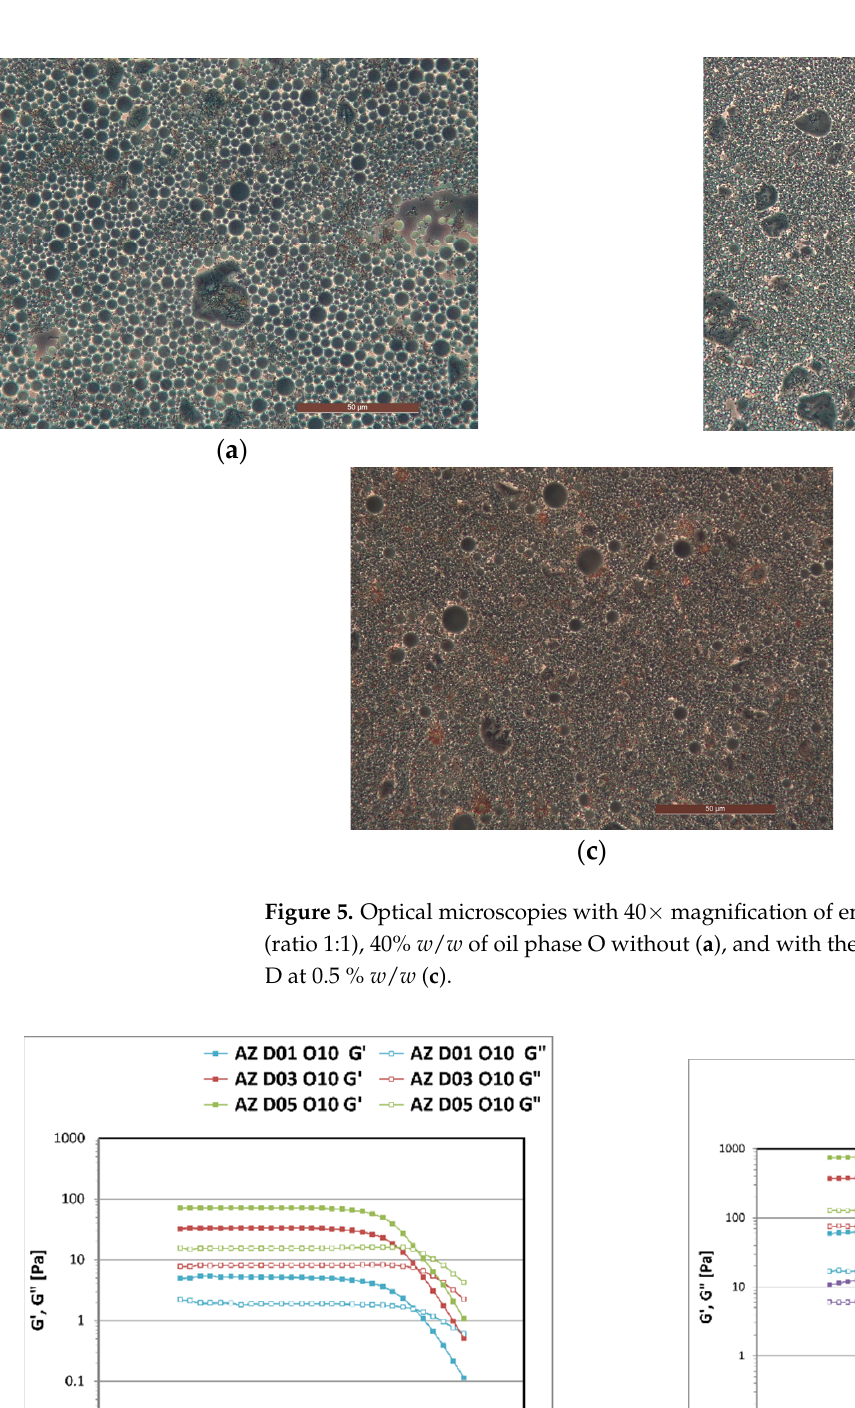
( b ) Figure 4. Optical microscopies with 40× magnification of emulsion AZ10 D03 ( a ) and AZ10 S03 ( b ) prepared with A-Z (ratio 1:1), 10% w/w of oily phase O and 0.3% w/w of polysaccharides D (Diutan gum) and S (Succinoglycan). We evaluated the influence of increasing the concentration of diutan gum (from 0.1 to 0.5% w/w) on the morphological, rheological, and texture properties of the emulsions formulated with 10% of powders (A-Z ratio 1:1) in presence of 10 or 40% w/w of the oily phase. All the systems were stable at the centrifuge test conducted both at 3000 and 4800 rpm. Morphological analyses performed through optical microscopy on the samples pre-